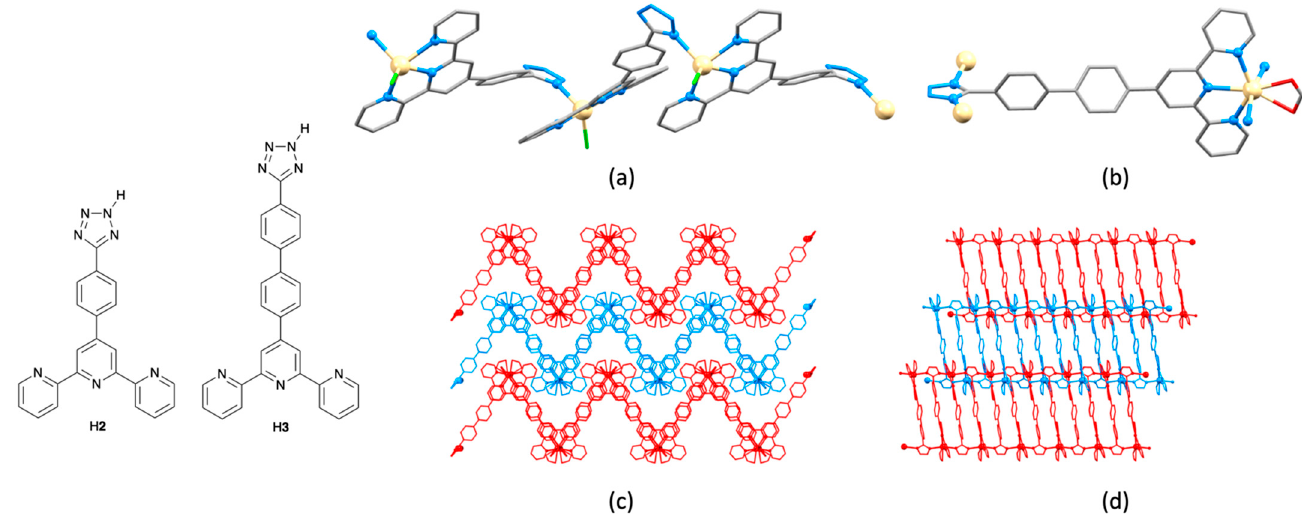
Figure 4. The structures of H 2 and H 3 , and of coordination polymers containing their conjugate bases. ( a ) Part of the 1D-chain in [CdCl( 2 )] n · n H 2 O (CSD refcode QIVRAR). ( b ) The building block in [Cd(O 2 CH)( 3 )] n · 2 n H 2 O (refcode PUCBUN). Packing of corrugated 2D-sheets in [Cd(O 2 CH)( 3 )] n · 2 n H 2 O viewed ( c ) down the c -axis and ( d ) down the c -axis, with adja ‐ cent layers colored red and blue.